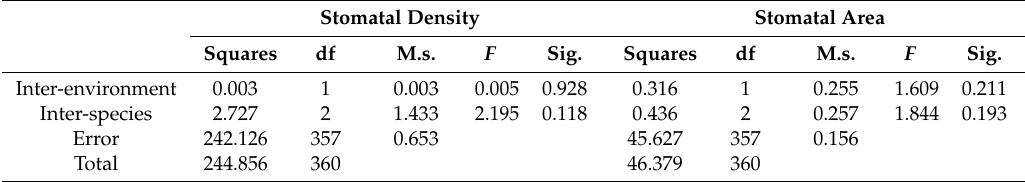
Table 5. Variance analysis of extraction and measured value